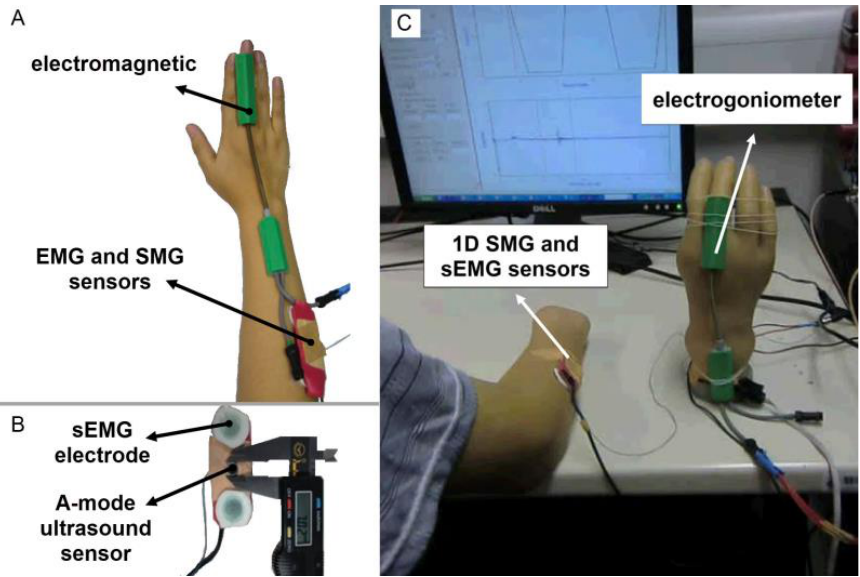
Figure 2. ( A ) The placement of the electro goniometer and sensors on healthy volunteers. ( B ) Placing A-mode small transducer (with a diameter of 7 mm) in between sEMG electrodes to collect both EMG and SMG signals from extensor carpi radialis muscle, simultaneously [51]. ( C ) The original image of the experimental setting, conducted by Guo and her colleagues in 2010. A-mode SMG setting for collecting SMG and EMG signals from a residual forearm for controlling a prosthesis to compare their performances, with the screen showing the A-mode ultrasound signal (lower half) and the guiding signal for muscle contraction (upper half).